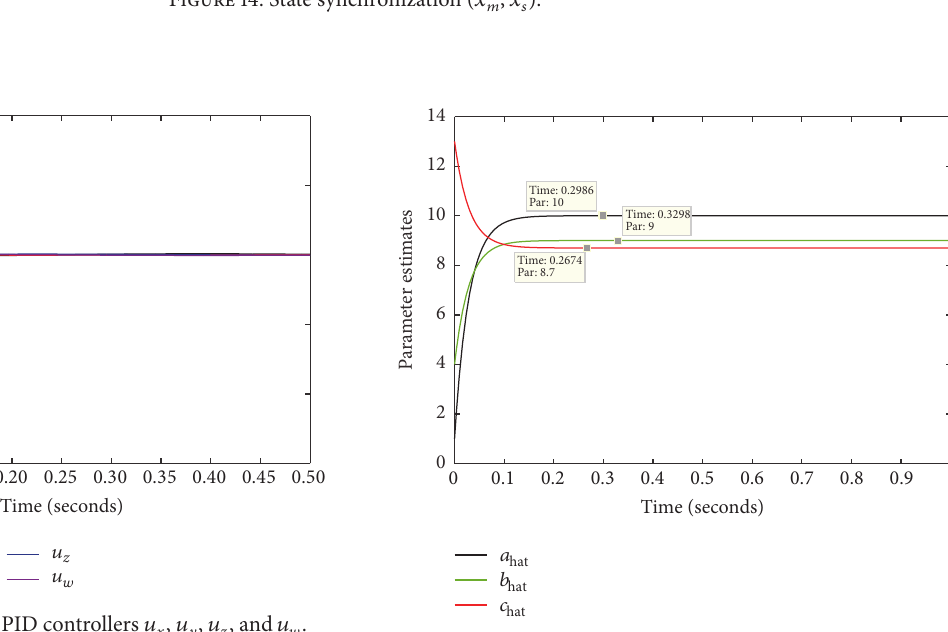
Figure 16: Time history of parameter